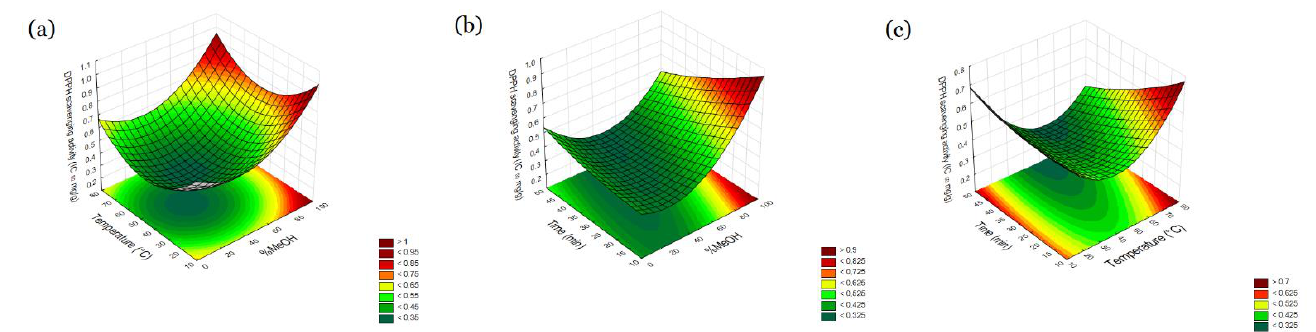
Figure 4. Response surface and contour plots percent of antioxidant activity as a function of methanol concentration (X 1) and temperature (X 2 ) ( a ), methanol concentration (X 1) and time (X 3 ) ( b ), temperature (X 2 ) and time (X 3 ) ( c ).